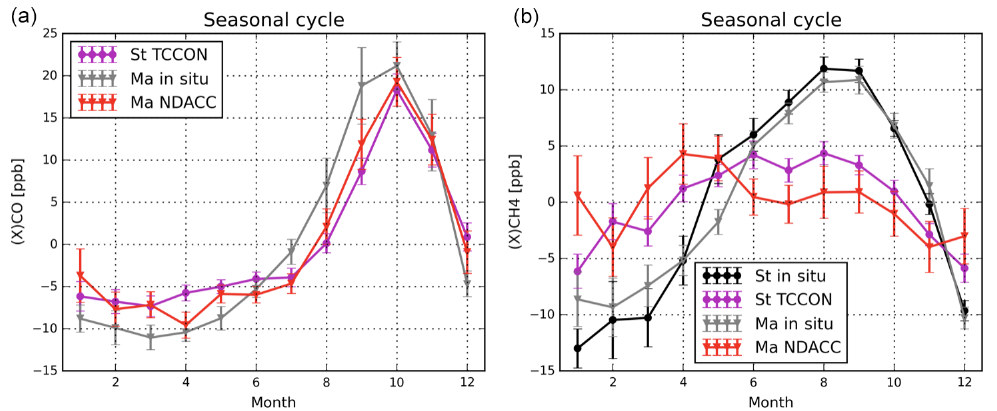
Figure 5. The seasonal cycles of CO (a) and CH 4 (b) from in situ and FTIR (NDACC and TCCON) measurements at St Denis and Maïdo. The error bar is 1 σ for all of the detrended data within that